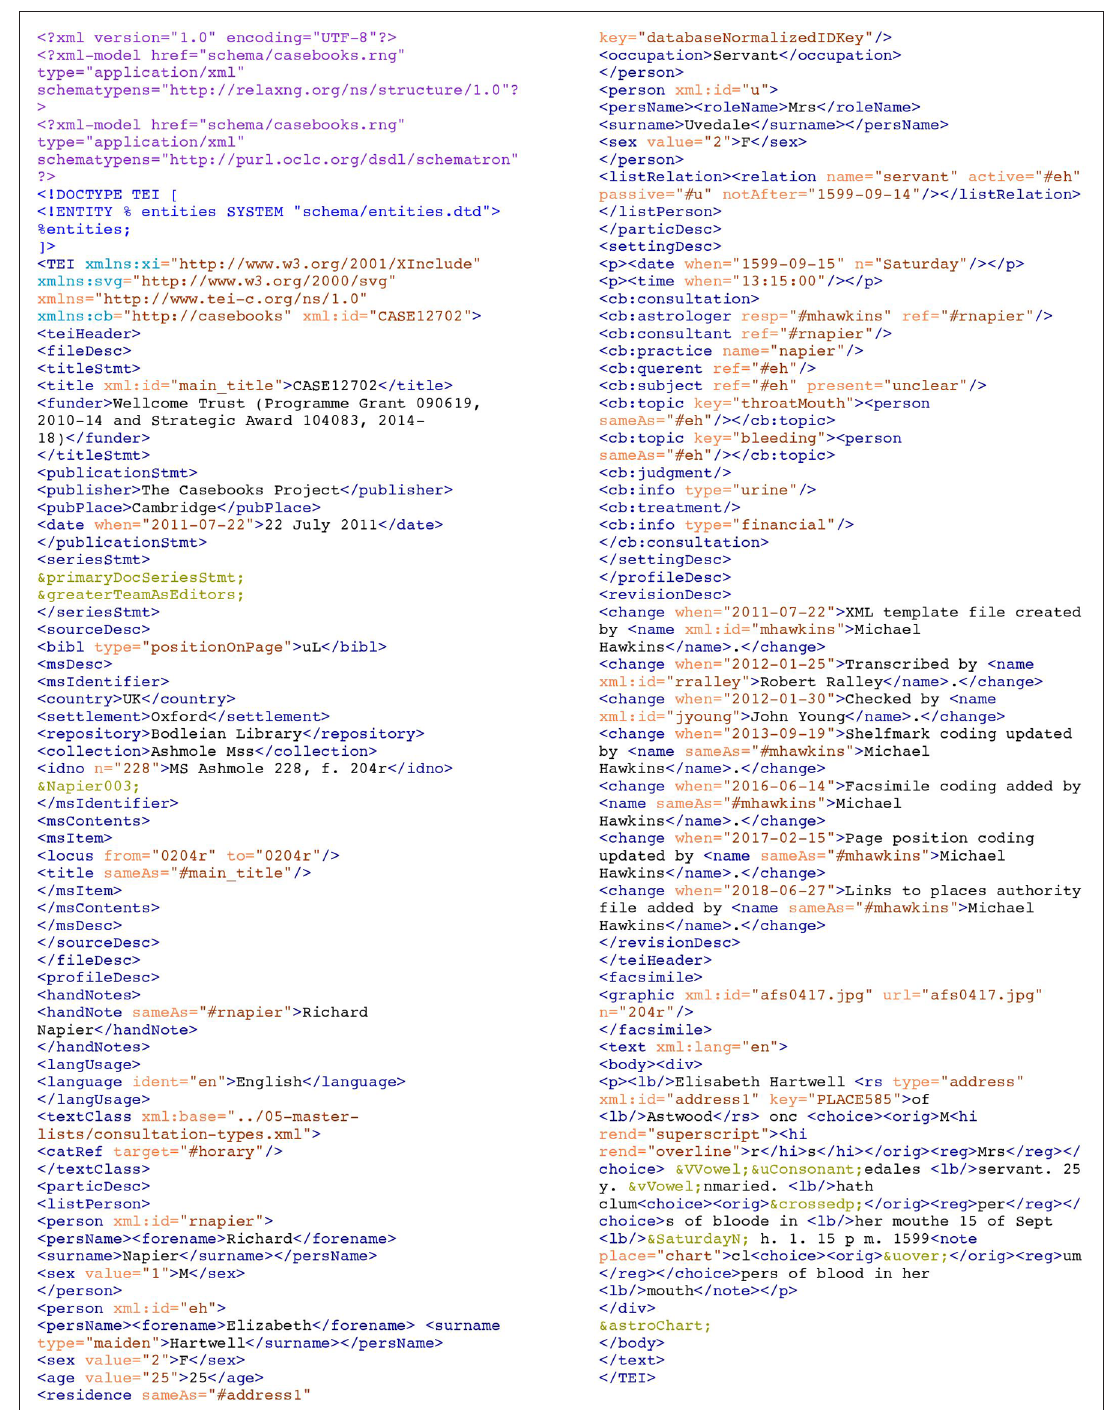
Figure 6: XML for